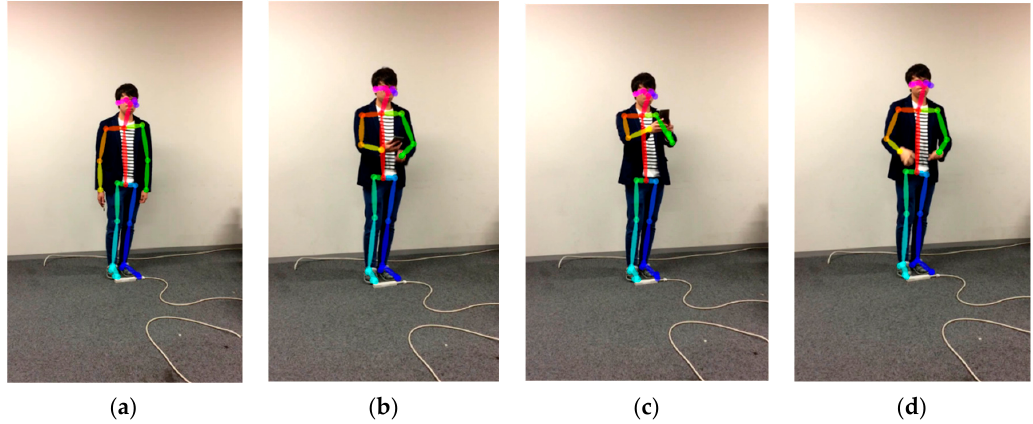
Figure 8. Visual skeleton information of photo-taking behavior extracted from OpenPose. ( a ) Initial